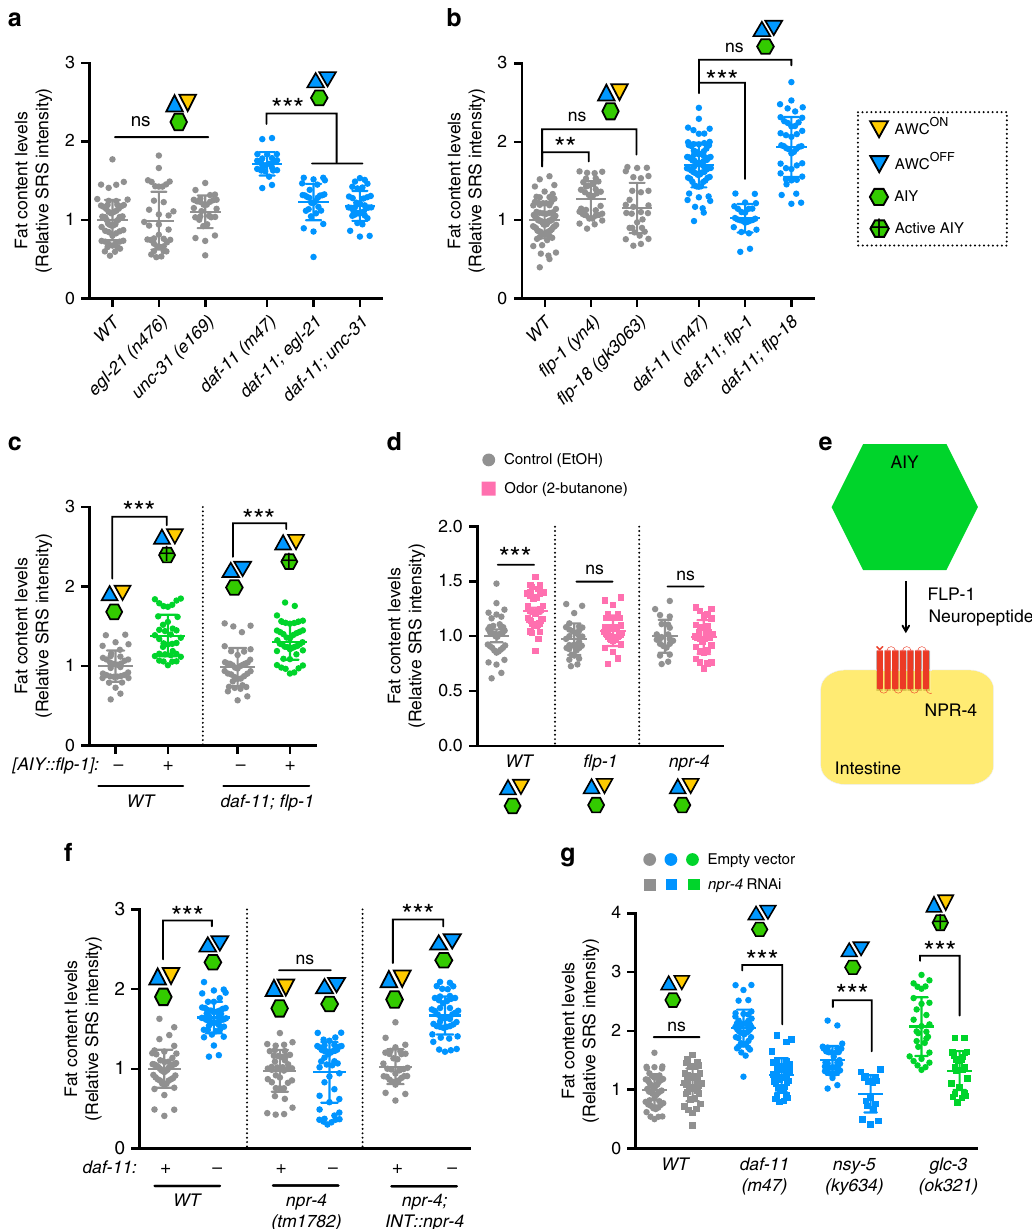
Fig. 6 Neuropeptide signals link olfactory neural circuit and fat metabolism. a Inactivation of either neuropeptide processing enzyme egl- 21 – carboxypeptidase E homolog, or neuropeptide secretion factor unc-31 – CAPS homolog suppresses the increased fat storage in the daf-11 mutants. Representative SRS images are in Supplementary Fig. 6k. b Among the neuropeptides that are secreted from AIY interneurons, deletion of fl p-1 , not fl p-18 , suppresses the increased fat storage in the daf-11 mutants. Representative SRS images are in Supplementary Fig. 6l. c AIY-speci fi c overexpression of fl p-1 increases fat storage under WT conditions. Restoration of fl p-1 expression only in AIY neurons is suf fi cient to rescue fat storage increase in the daf-11; fl p-1 double mutants. Representative SRS images are in Supplementary Fig. 6m. d Mutation of either fl p-1 neuropeptide or its putative receptor npr-4 fully suppresses the fat storage increase conferred by the 2-butanone odor exposure. Representative SRS images are in Supplementary Fig. 6n. e Scheme of FLP-1 neuropeptides released from AIY interneurons acting through their putative receptor, NPR-4 that cell-autonomously regulates fat levels in the lipid